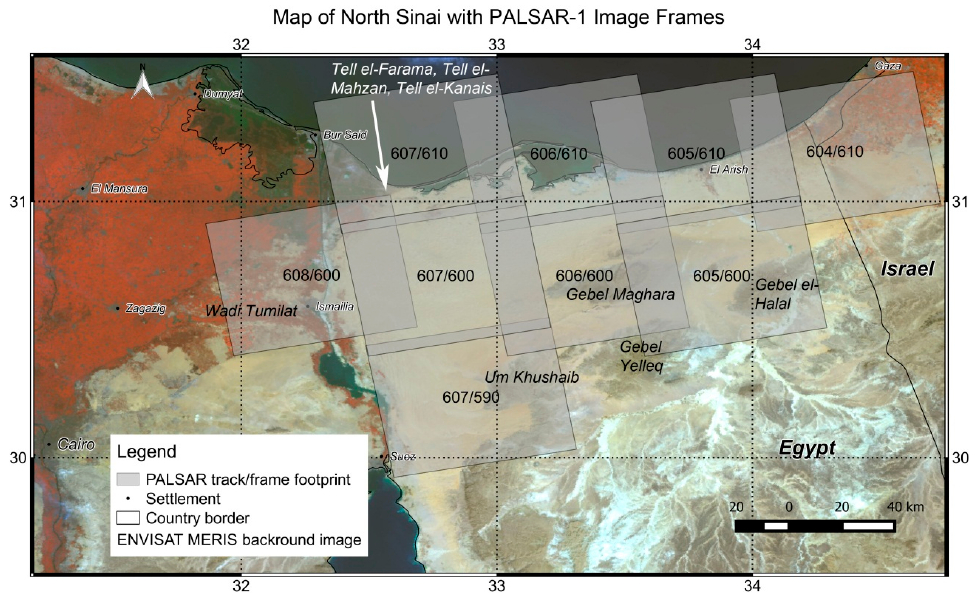
Figure 1. Map of the study area. Background image is a near-infrared and visible false colour composite of the ENVISAT Medium Resolution Imaging Spectrometer (MERIS). 300 m resolution. Band 10 (754 nm) displayed as red, band 5 (560 nm) as green, and band 2 (443 nm) as blue. Overlain on the MERIS image are the footprints of the Phased Array type L-band Synthetic Aperture Radar (PALSAR-1) images used for the mosaic, with their corresponding track/frame identification numbers. Data provided by European Space Agency (ESA).